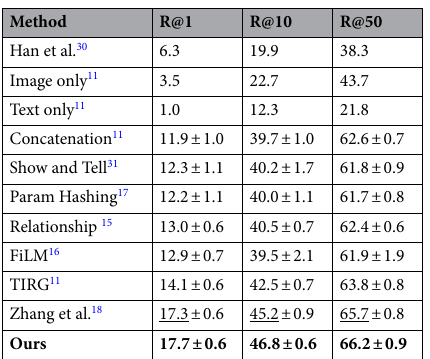
Table 1. Comparison results of retrieval performance on Fashion200k dataset.